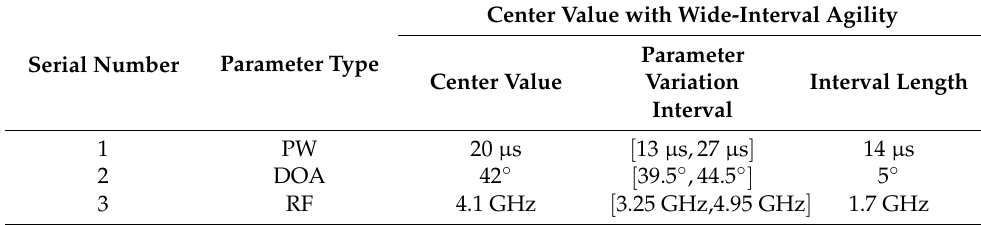
Table 3. Simulation parameter setting of random interference pulse signal.